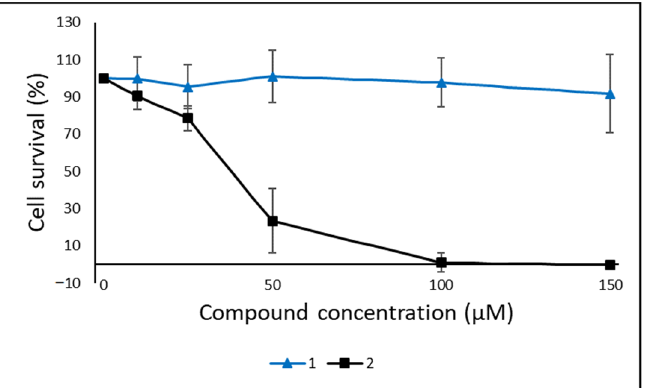
Figure 6. Cytotoxic activity of 1 and 2 against A2058 human melanoma cells. The compounds were tested in three experiments with at least eight technical replicates in total.